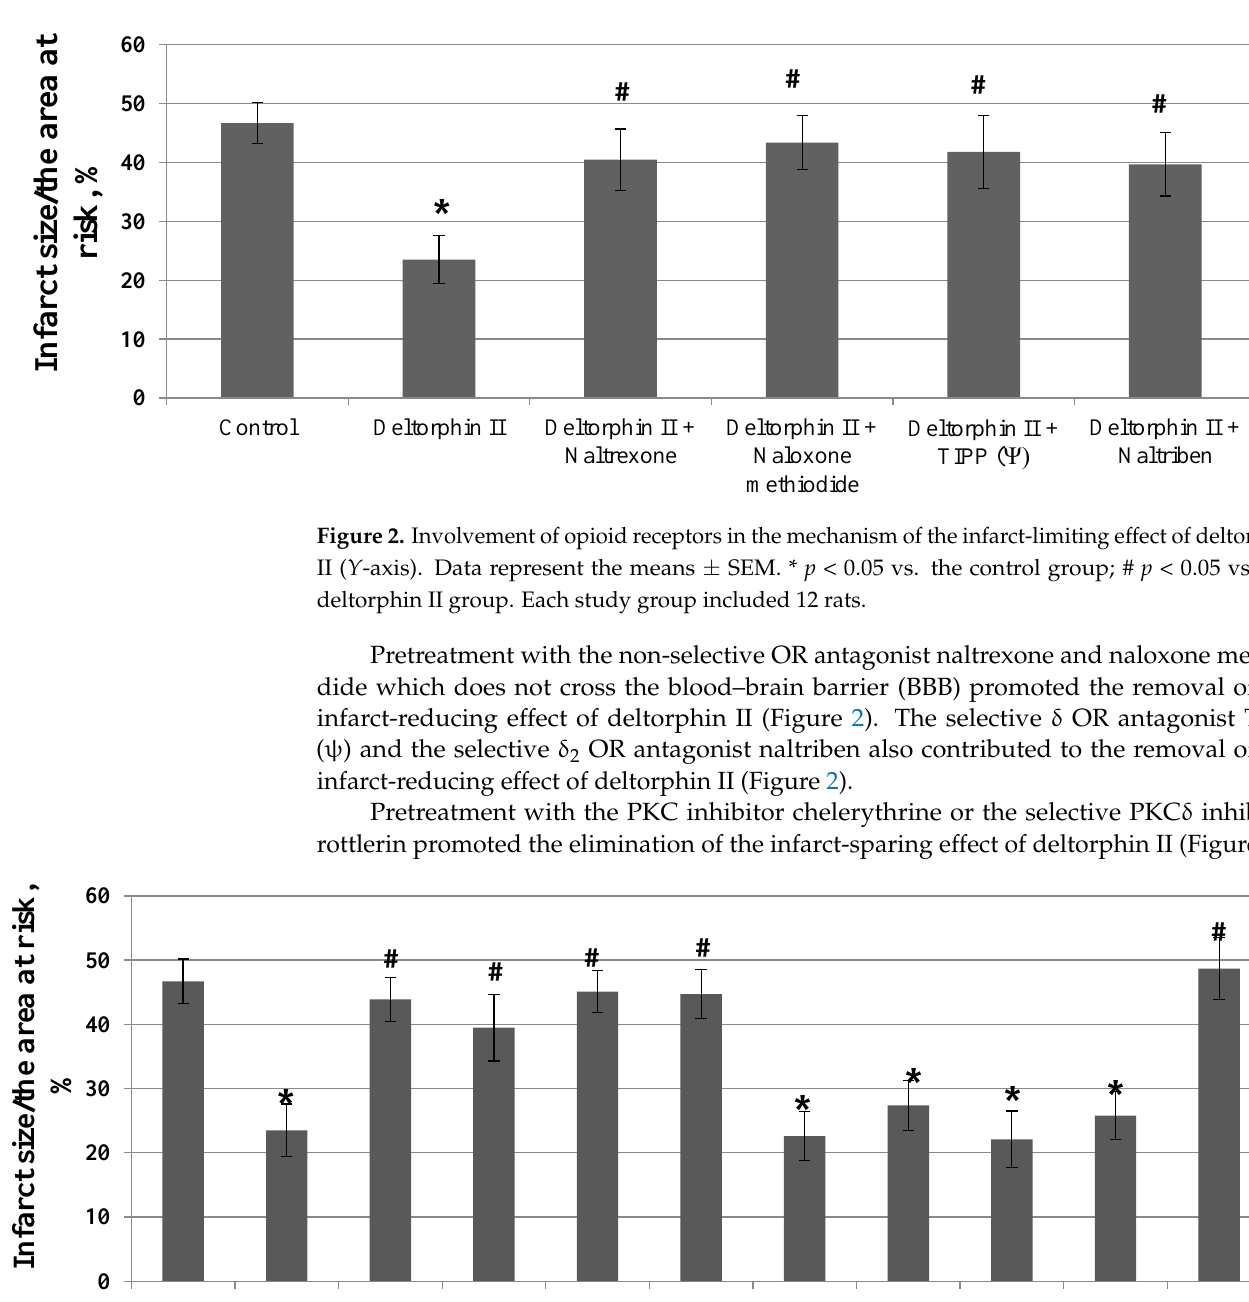
represent the means ± SEM. Each study group included 12 rats.